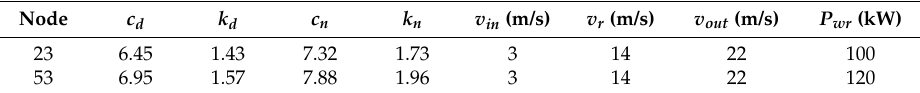
Table 9. Parameters in probability model of wind power.